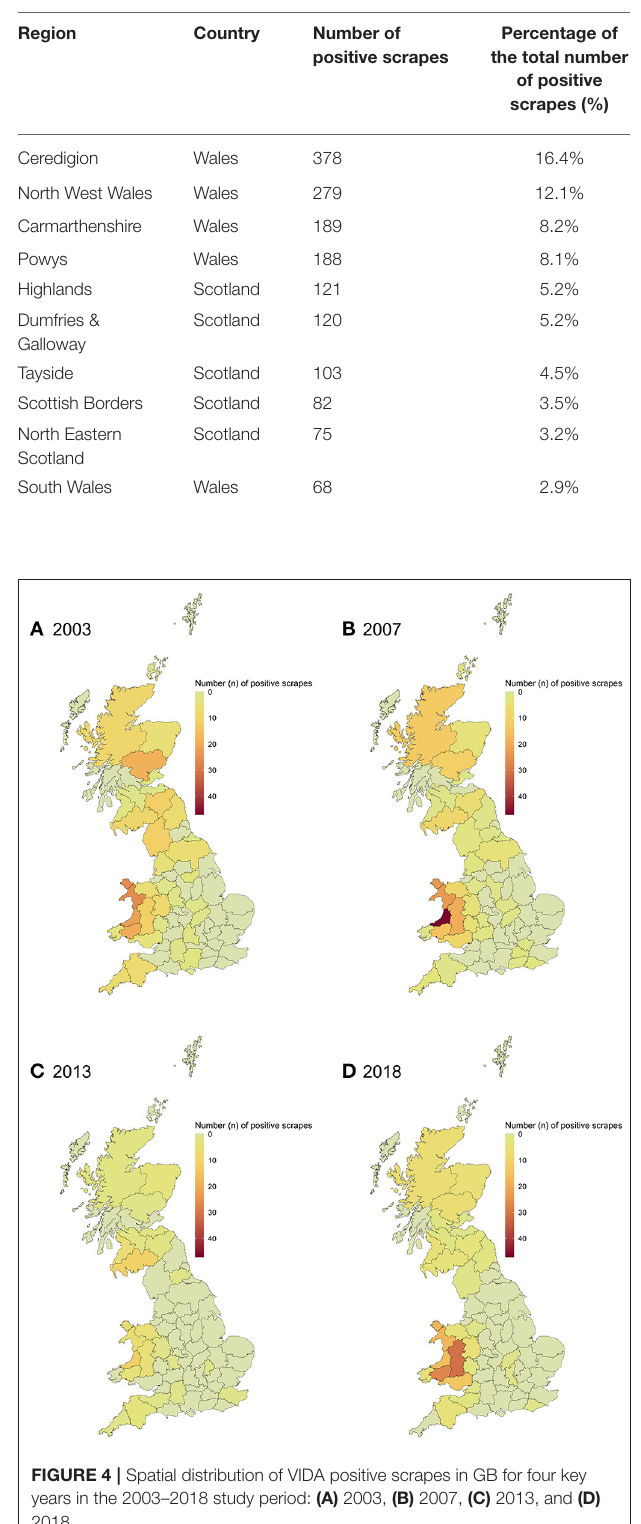
TABLE 1 | The ten regions with the highest totals of VIDA positive scrapes (sheep scab diagnoses) for GB across 2003–2018.